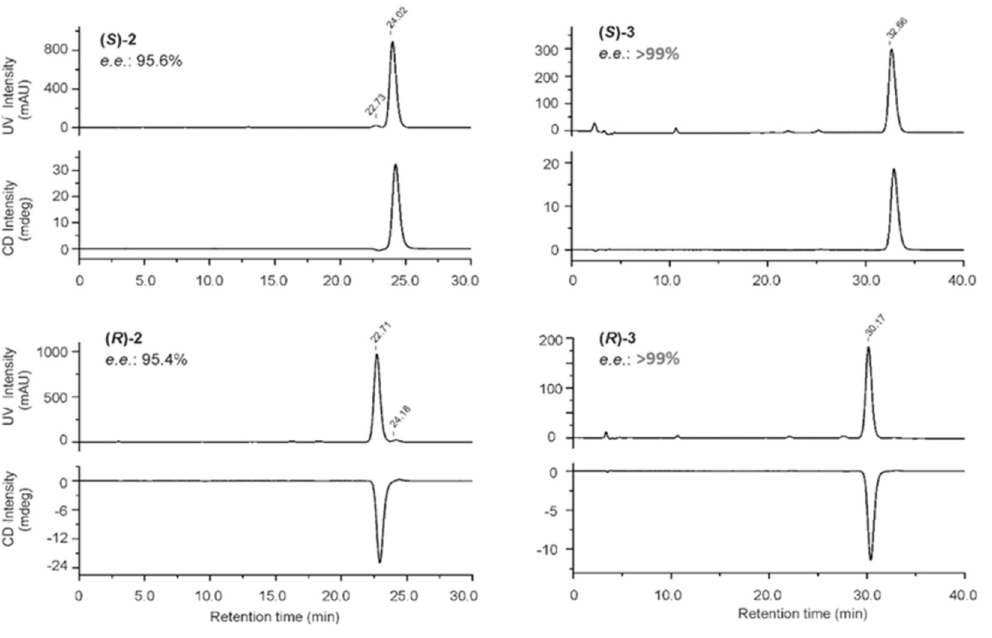
Figure 3. Chromatograms of the chiral HPLC separation of ( S )- and ( R )- 2 and ( S )- and ( R )- 3 . Conditions: (a) Column: CHIRALPAK IB, (b) Mobile phase composition: ACN/aq. 20 mM NH 4 OAc (46/54, v / v for ( S )- and ( R )- 2 and 34/66, v / v for ( S )- and ( R )- 3 ), (c) CD detection at 285 nm.